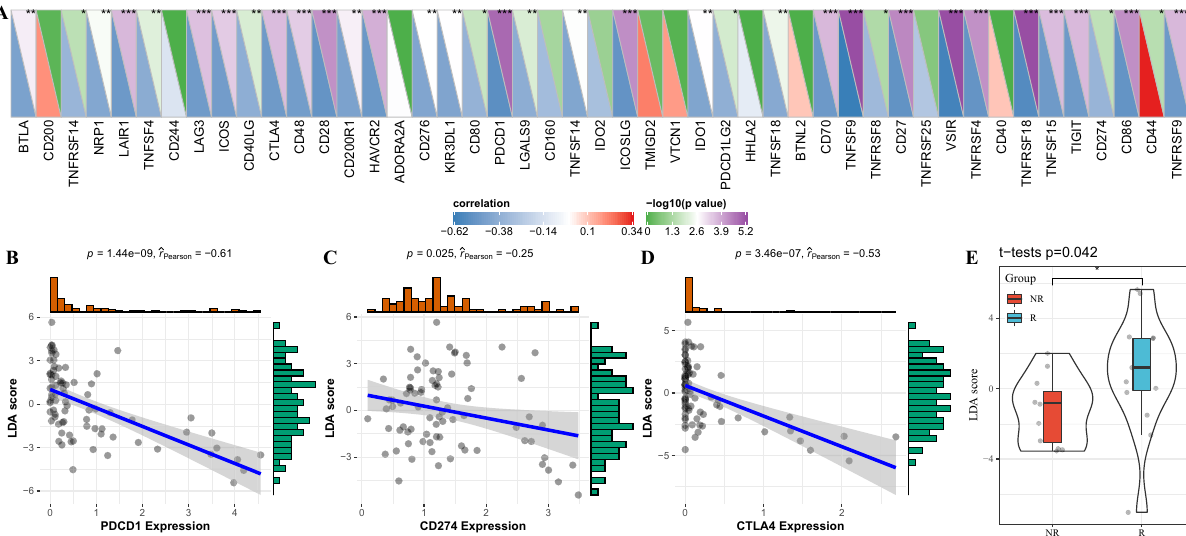
Figure 6. Relationship between LDA score and immunotherapy. ( A ) Relationship between LDA score and immune checkpoint. ( B ) Correlation between LDA score and PDCD1. ( C ) Correlation between LDA score and CD274 expression. ( D ) Correlation between LDA score and CTLA4 expression. ( E ) The LDA score of patients who responded to PD-1-blocking immunotherapy was significantly higher than that of patients did not respond to immunotherapy. * P < 0.05; ** P < 0.01; *** P <